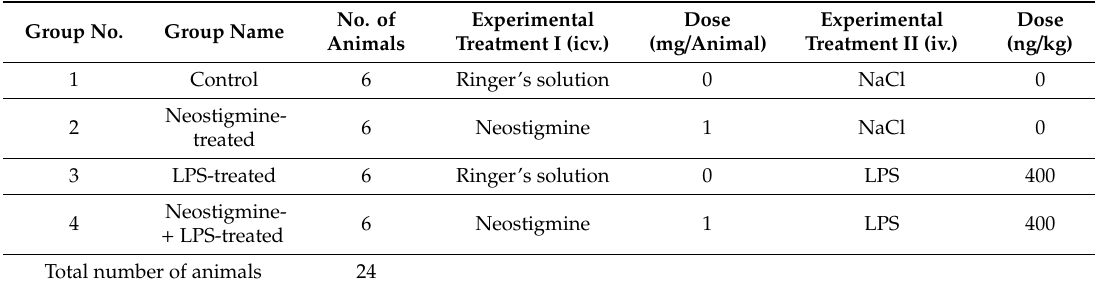
Table 4. Scheme of the